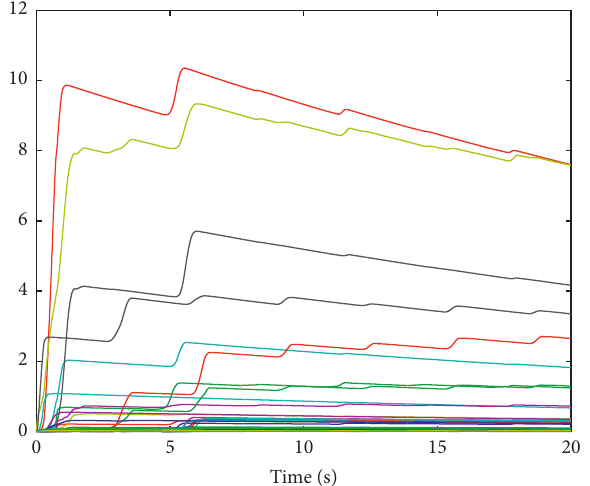
Figure 7: Fuzzy parameter for θ